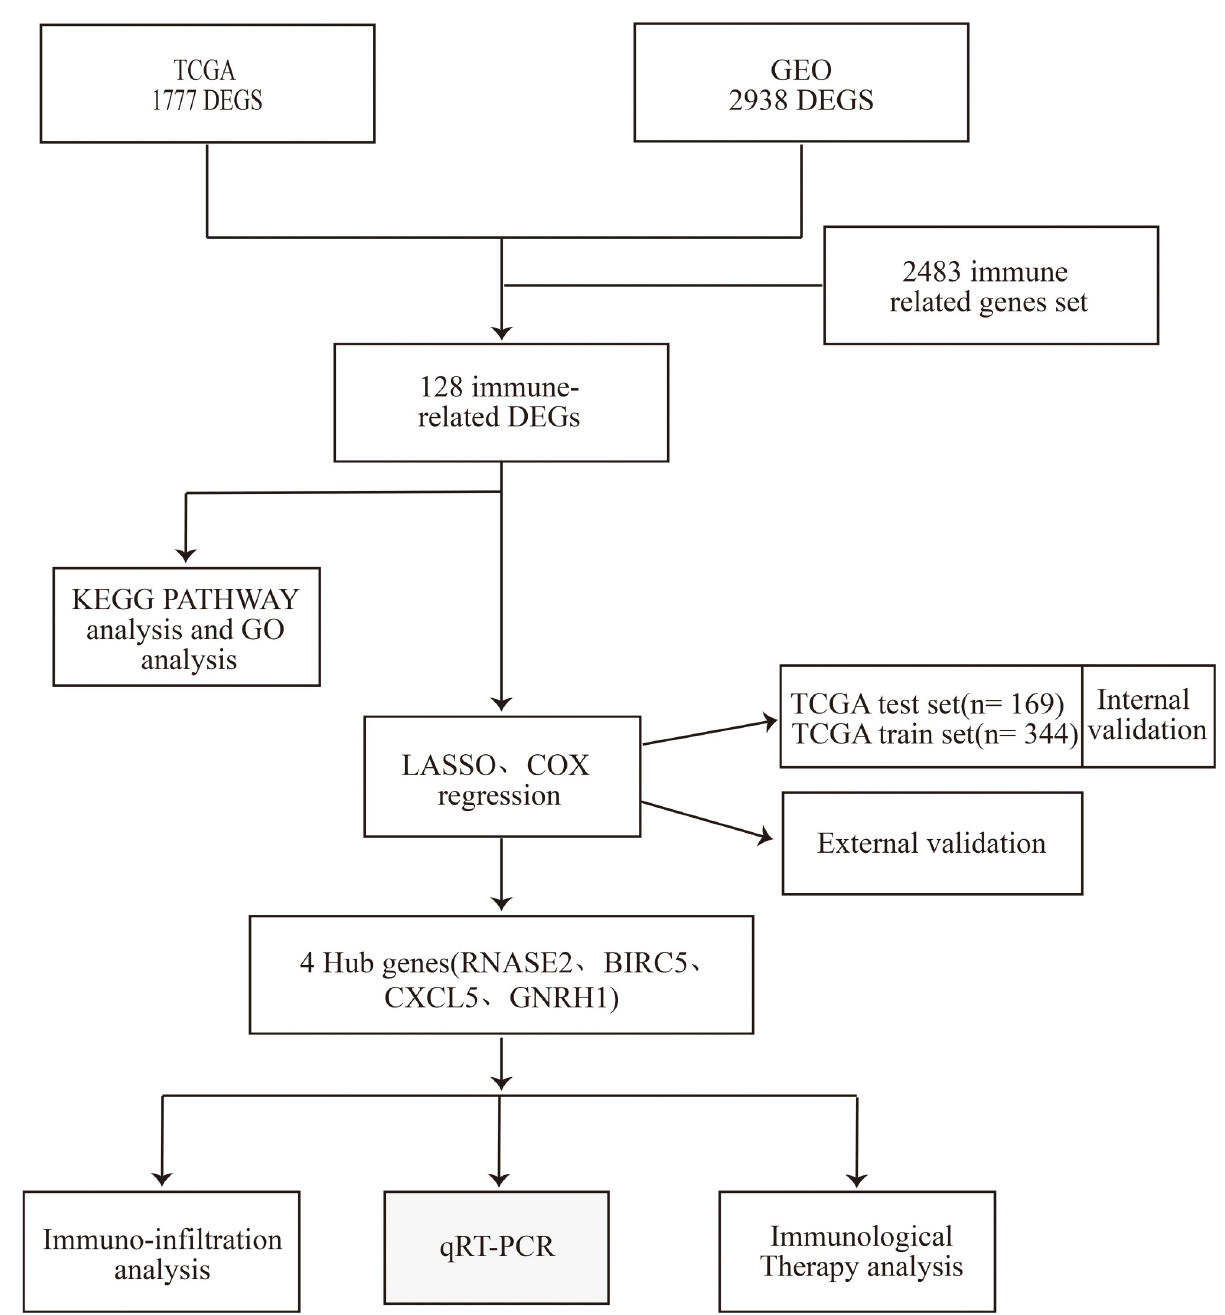
Fig 2. Schematic of the study